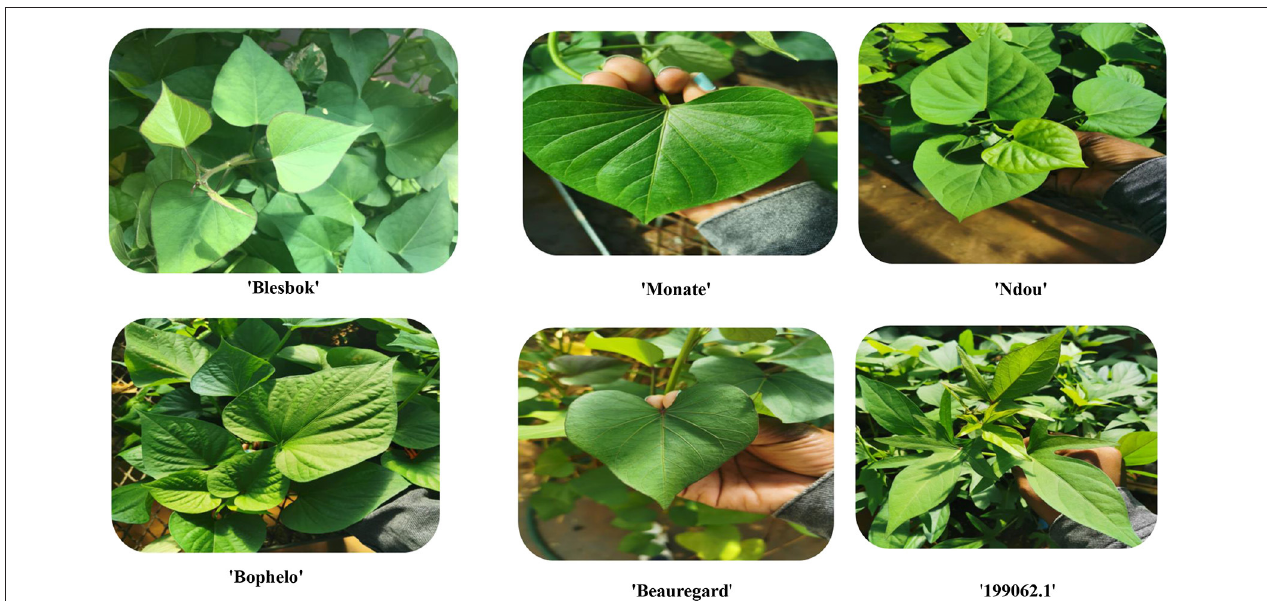
FIGURE 1 | Leaves of different cultivars of sweet